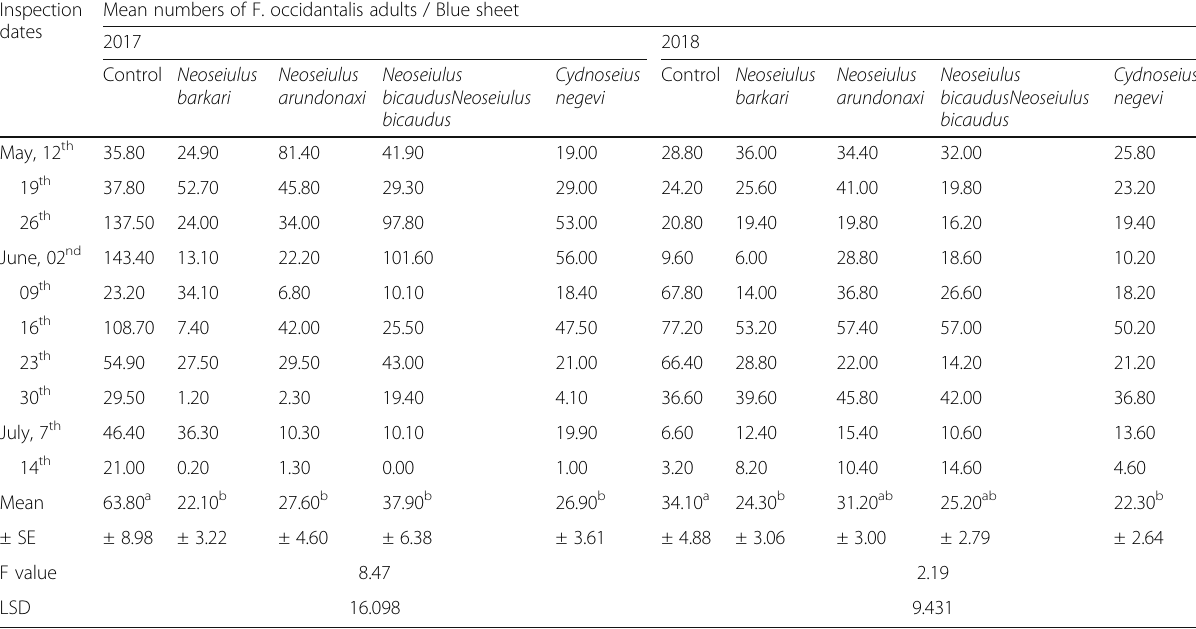
Table 4 Mean numbers of WFT, Frankliniella occidentalis , adults/blue sticky trap after the releasing of phytoseiid mites on pepper greenhouse Inspection